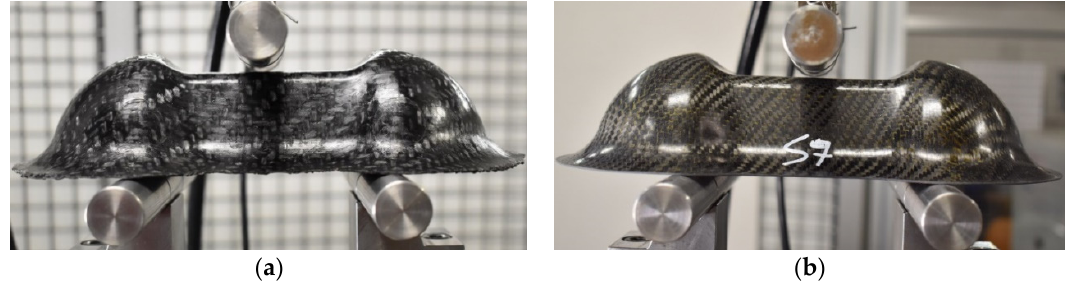
Figure 11. Double Dome specimens in GF/PP ( a ) and CF/EP-Solvay ( b ) before the bending test.